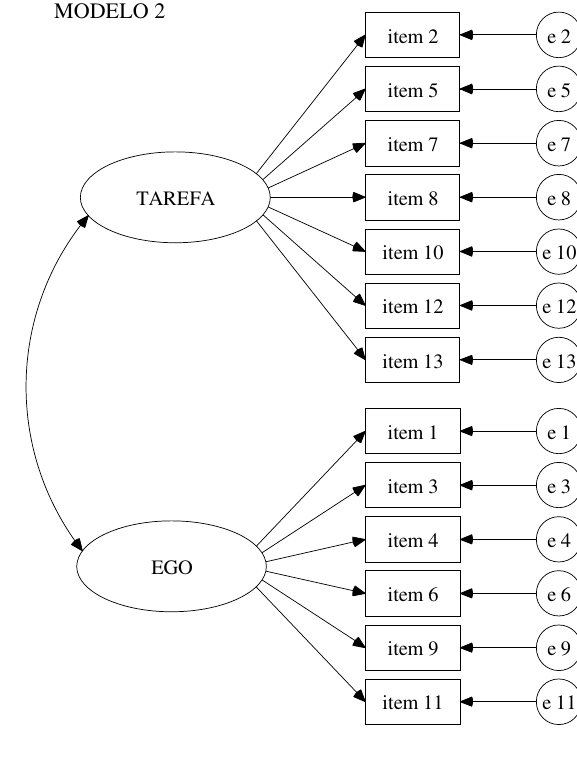
Figura 1 . Modelos de medição testados no presente